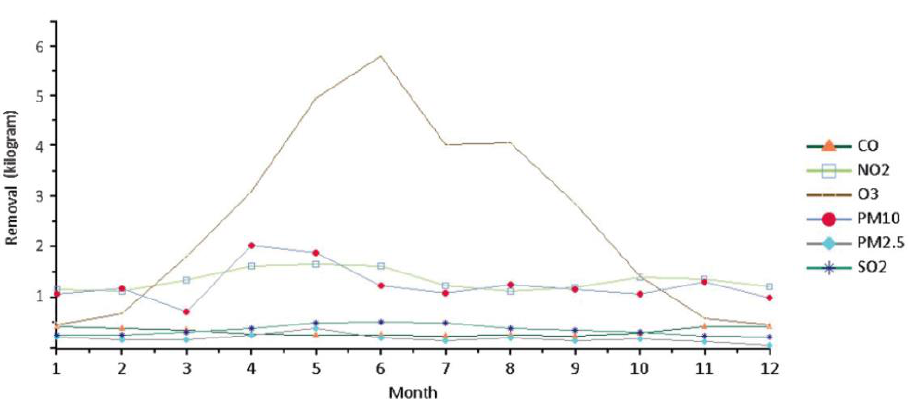
Figure 6. Pollution removal by trees and shrubs — monthly removal.